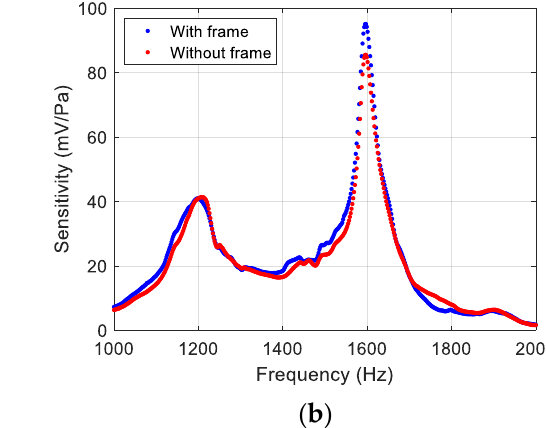
Figure 5. Measured frequency response of the sensor at normal incidence: ( a ) without the housing and ( b ) with the housing and frame (blue dots), and with the housing only (red dots).